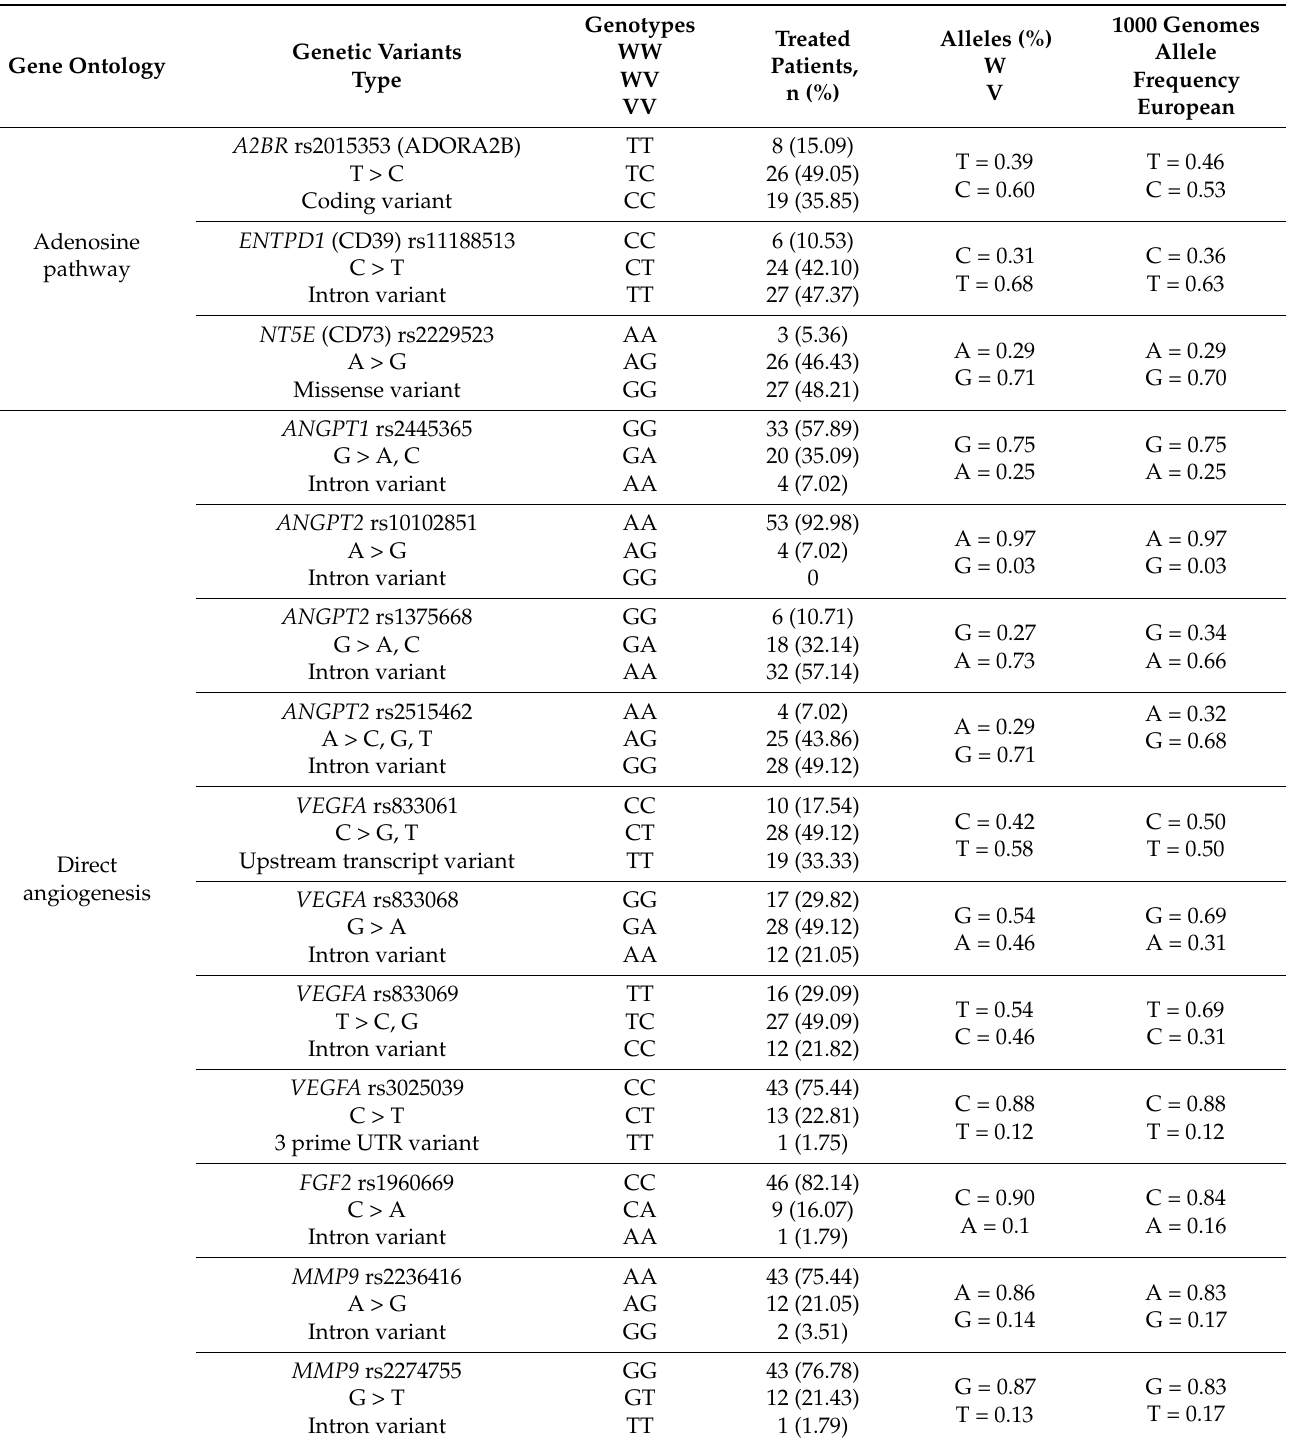
Table 2. Genotype frequencies of the SNPs examined and classification of genes according to their biological process (gene ontology). Indicated are allele frequencies of the SNPs analysed found in the 1000 Genomes database [22]. (W = wild-type allele, V = Variant